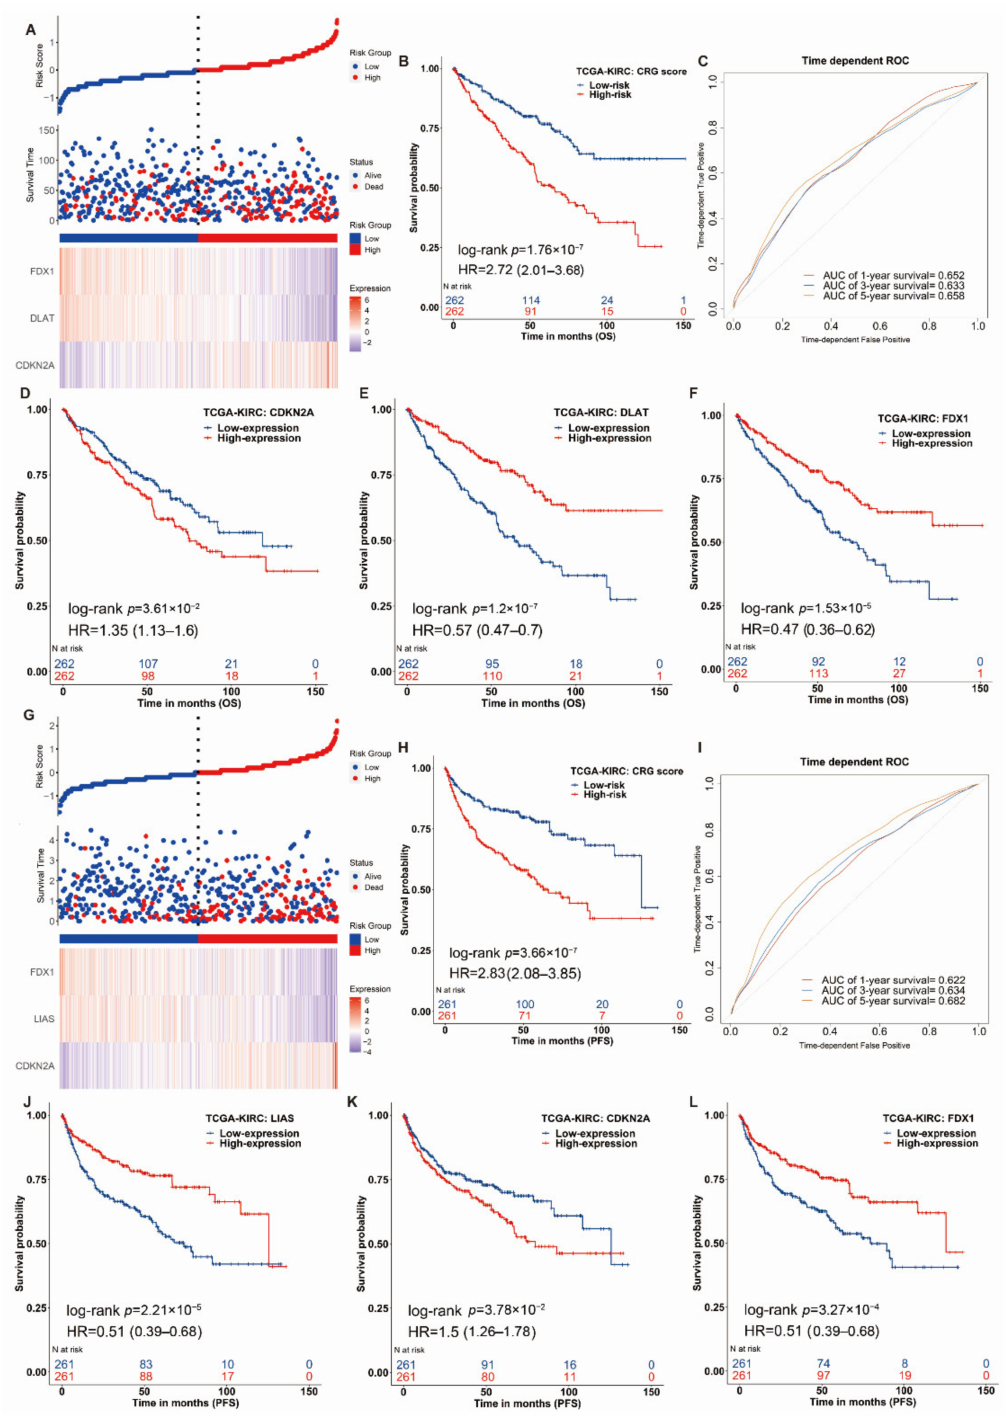
Figure 3. Clinical relevance of CRGs in the ccRCC patients of TCGA. For OS outcome, ( A ) distribution of risk score, survival status and the expression of prognostic CRGs, ( B ) Kaplan − Meier plot of the CRG signature and overall survival, ( C ) ROCs for one-year, three-year and five-year survival prediction. Kaplan − Meier plot for the expression of ( D ) CDKN2A ( E ) DLAT and ( F ) FDX1 and overall survival. For PFS outcome, ( G ) distribution of risk score, status and the expression of prognostic CRGs, ( H ) Kaplan − Meier plot of the CRG signature and progression-free survival. ( I ) ROCs for one-year, three-year and five-year progression-free survival prediction. Kaplan − Meier plots of the expression of ( J ) LIAS , ( K ) CDKN2A and ( L ) FDX1 and progression-free survival. The hazard ratios (HRs) are evaluated by Cox proportional hazard models. OS: overall survival, PFS: progression-free survival and ROC: receiver operating characteristic